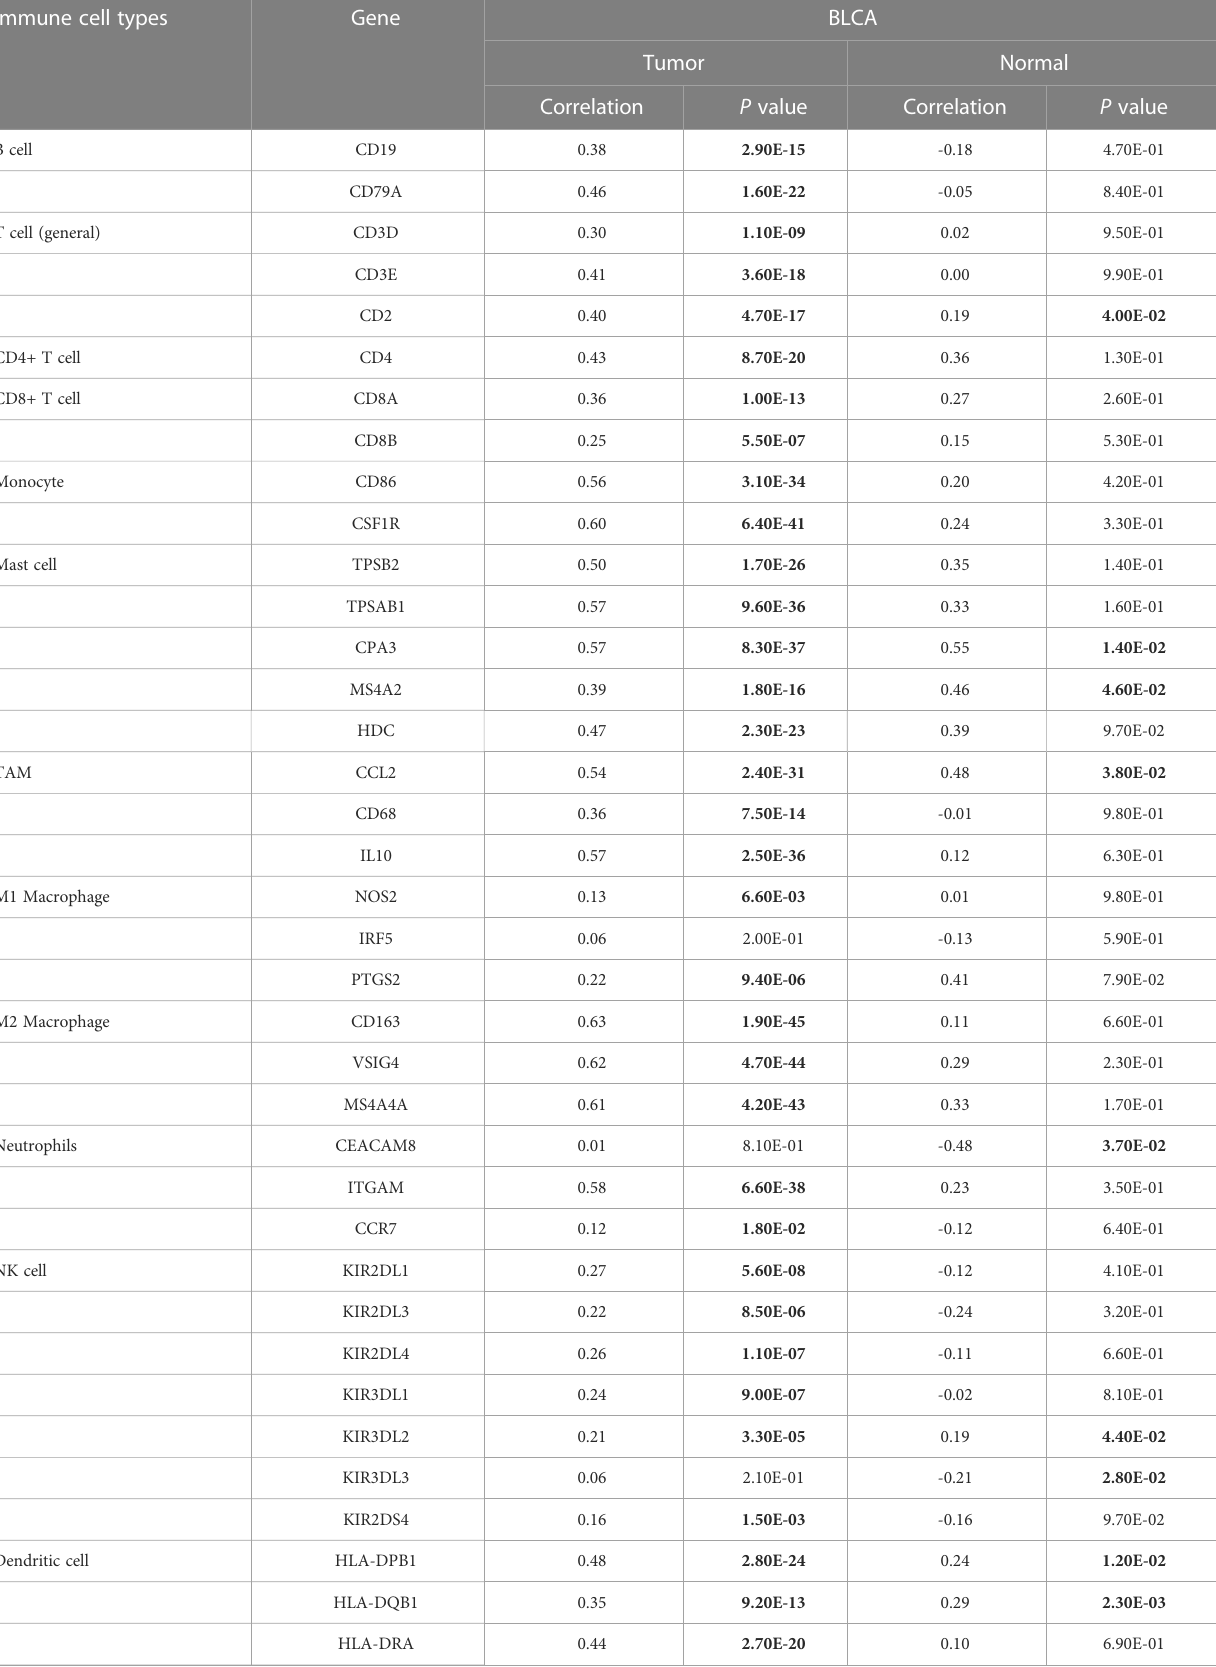
TABLE 2 Correlation analysis between COL10A1 and immune cell marker and immune checkpoint genes in